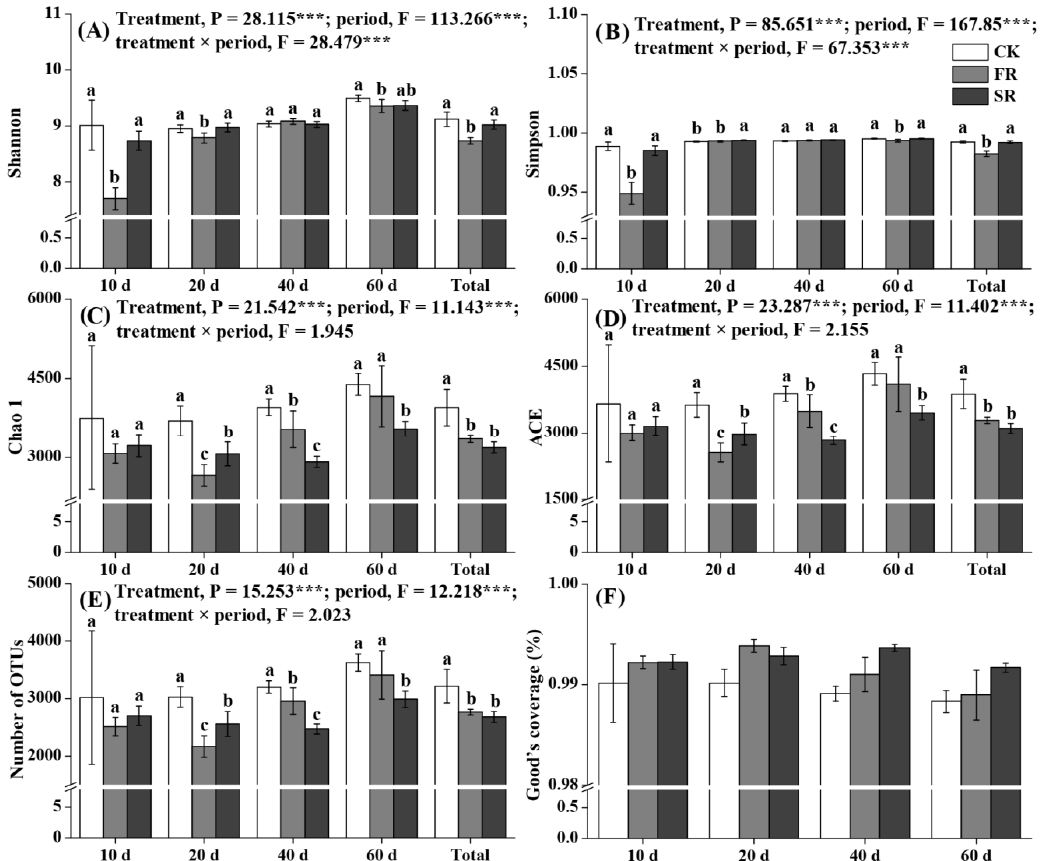
Figure 3. Alpha diversity based on Illumina MiSeq sequencing analysis of the soil bacteria in response to rice straw application. ( A ) Shannon, ( B ) Simpson, ( C ) Chao 1, ( D ) ACE, ( E ) Number of OTUs and ( F ) Good’s coverage. CK, no straw application; FR, one-year straw application; SR, two-year straw application. Labels of the abscissa axis indicate the survey time (day after sowing), and total indicates the mean value for each period. Error bars indicate the standard error and different letters indicate significant differences at the 0.05 level (Tukey’s HSD test). The text in the figure represents the effects of the treatment and period based on the repeated-measures ANOVA. * p < 0.05, ** p < 0.01 and *** p < 0.001.